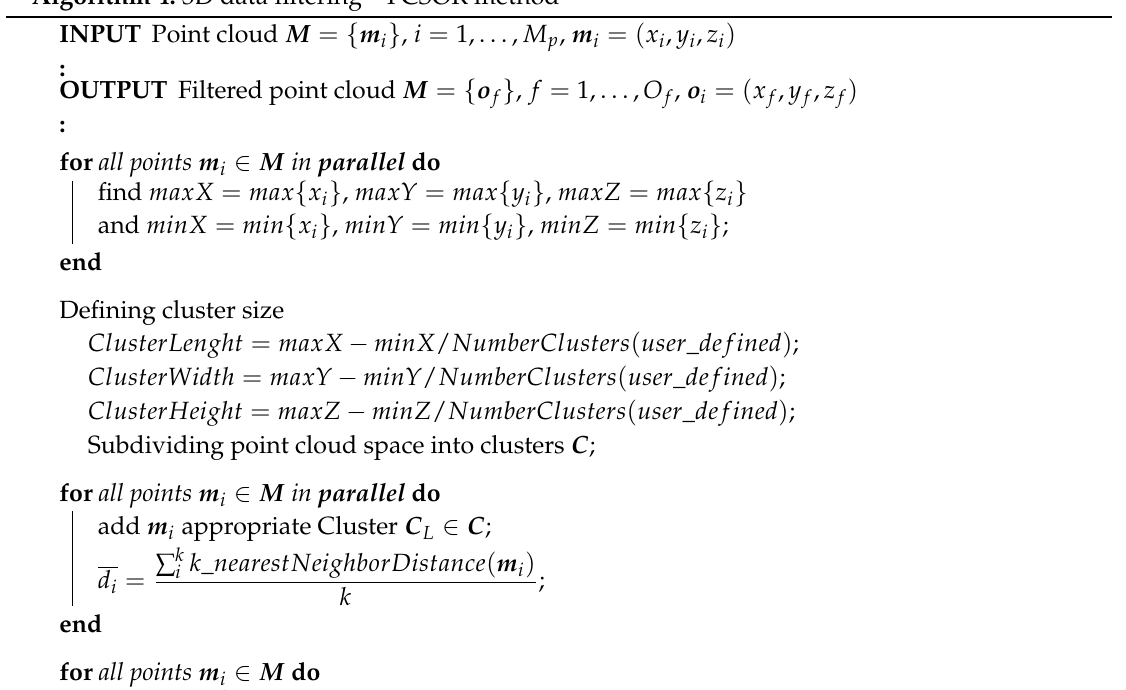
Algorithm 4: 3D data filtering—FCSOR